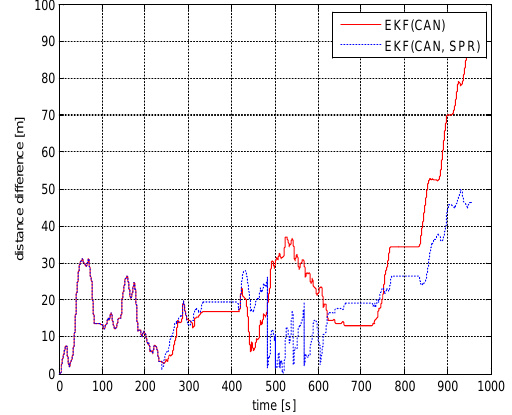
Figure 14. The estimated position difference Unit